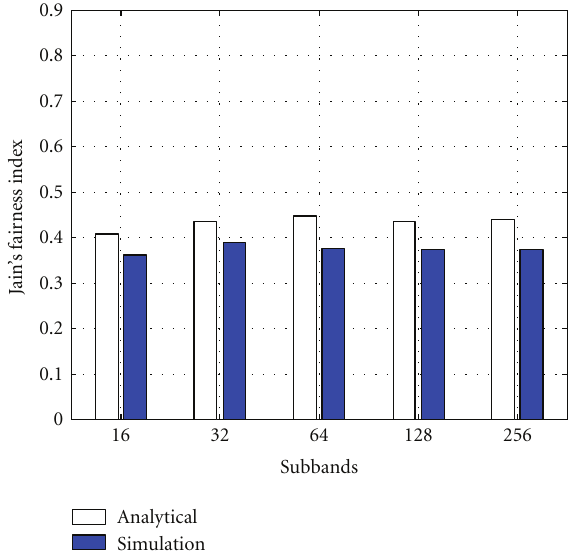
Figure 11: Mean packet delay versus tra ffi c load for the proposed algorithm analytically and by simulation for PF with OFDMA and PF with